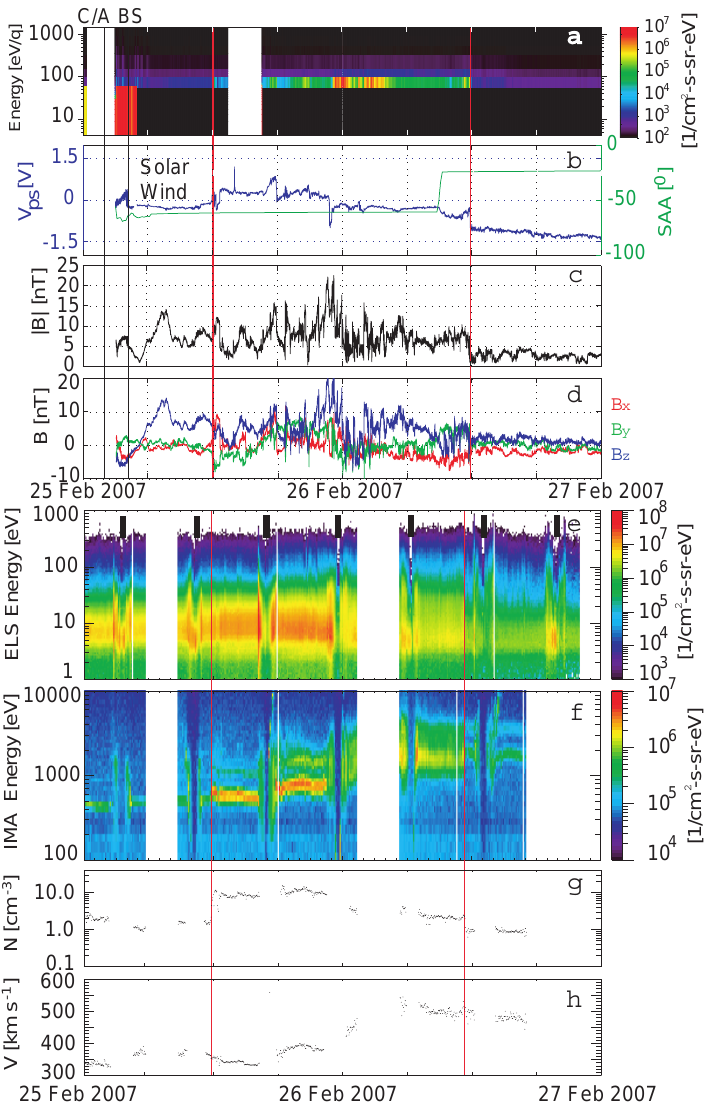
Fig. 2. Time series of (a) Rosetta IES omni-directional electron spectra, (b) Rosetta LAP probe-to-spacecraft potential V ps measured at a rate of 0.9 Hz (blue) and Rosetta SAA (green), Rosetta MAG (c) magnetic field magnitude and (d) components in MSO coordinates, (e) MEX ELS omni-directional electron energy spectra, (f) MEX IMA omni-directional ion energy spectra as well as (g) MEX IMA ion density and (h) total velocity. The interval of high pressure is marked by red lines, while the closest approach of Rosetta and the outbound BS crossing is marked by black lines. The thick bars in panel (e) mark the closest approach of MEX during each